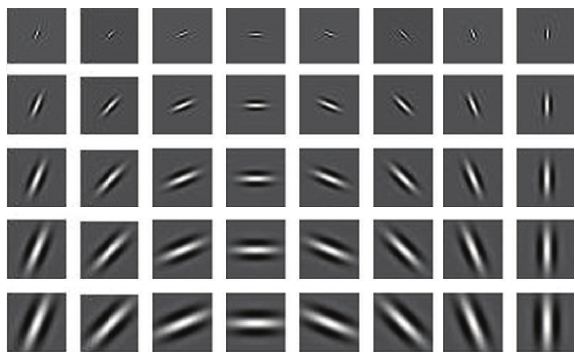
Figure 2: Gabor wavelets filter bank which has been used for the active basis